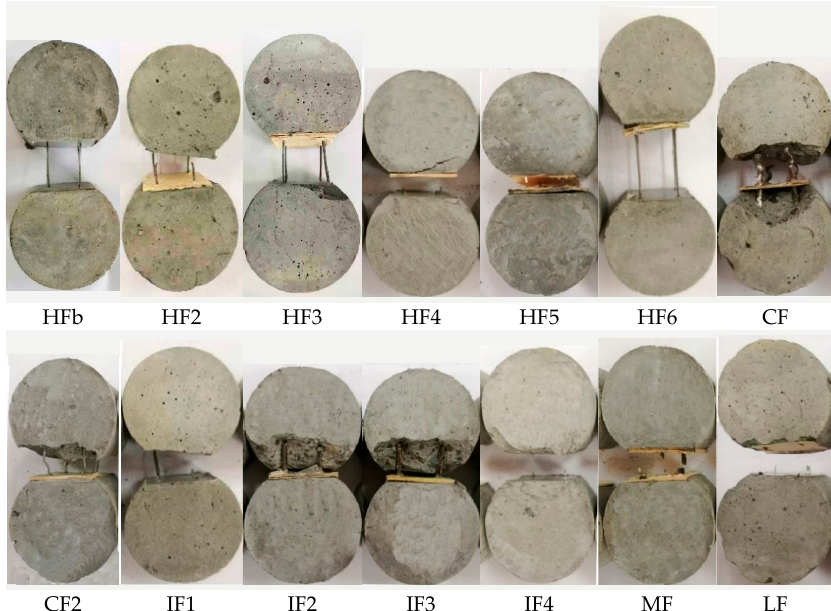
Figure 9. Typical failure modes of pull-out tests with different steel fibers. Table 4. Failure modes of different deformed steel fiber.